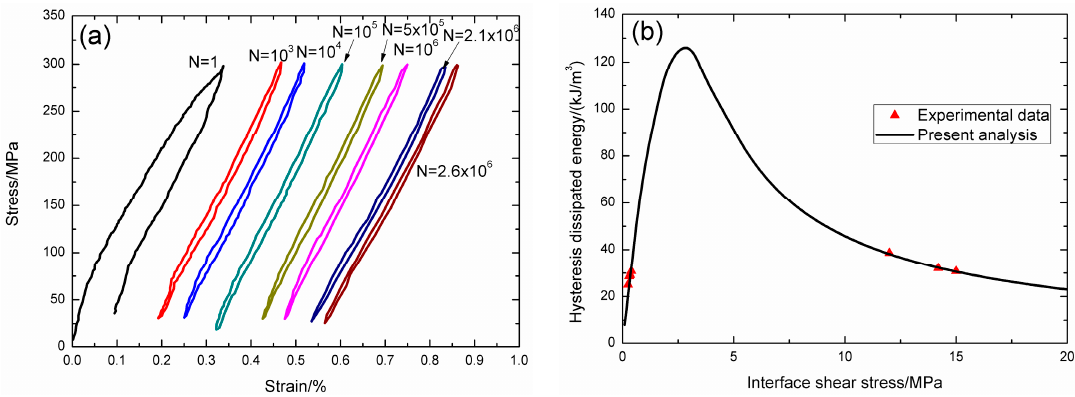
Figure 12. ( a ) The experimental fatigue hysteresis loops corresponding to different cycle number; and ( b ) the experimental and theoretical fatigue hysteresis dissipated energy versus interface shear stress curve of 2D woven C/SiC composite under σ max = 300 MPa at 1200 °C in vacuum. Table 7. The interface shear stress of 2D woven C/SiC composite corresponding to different applied cycles under fatigue peak stress of σ max = 300 MPa at 1200 °C in vacuum.